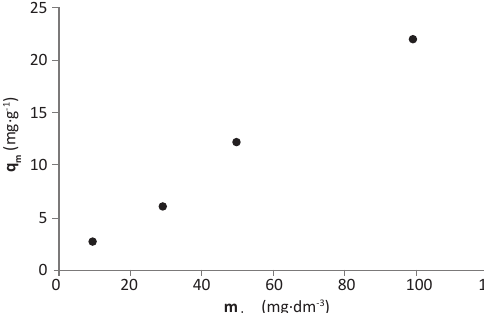
figURe 6. The effect of initial dye concentration on the adsorption of MB onto poplar sawdust (γ t=120 min, T=298.15 K, pH=7, 150 rpm).